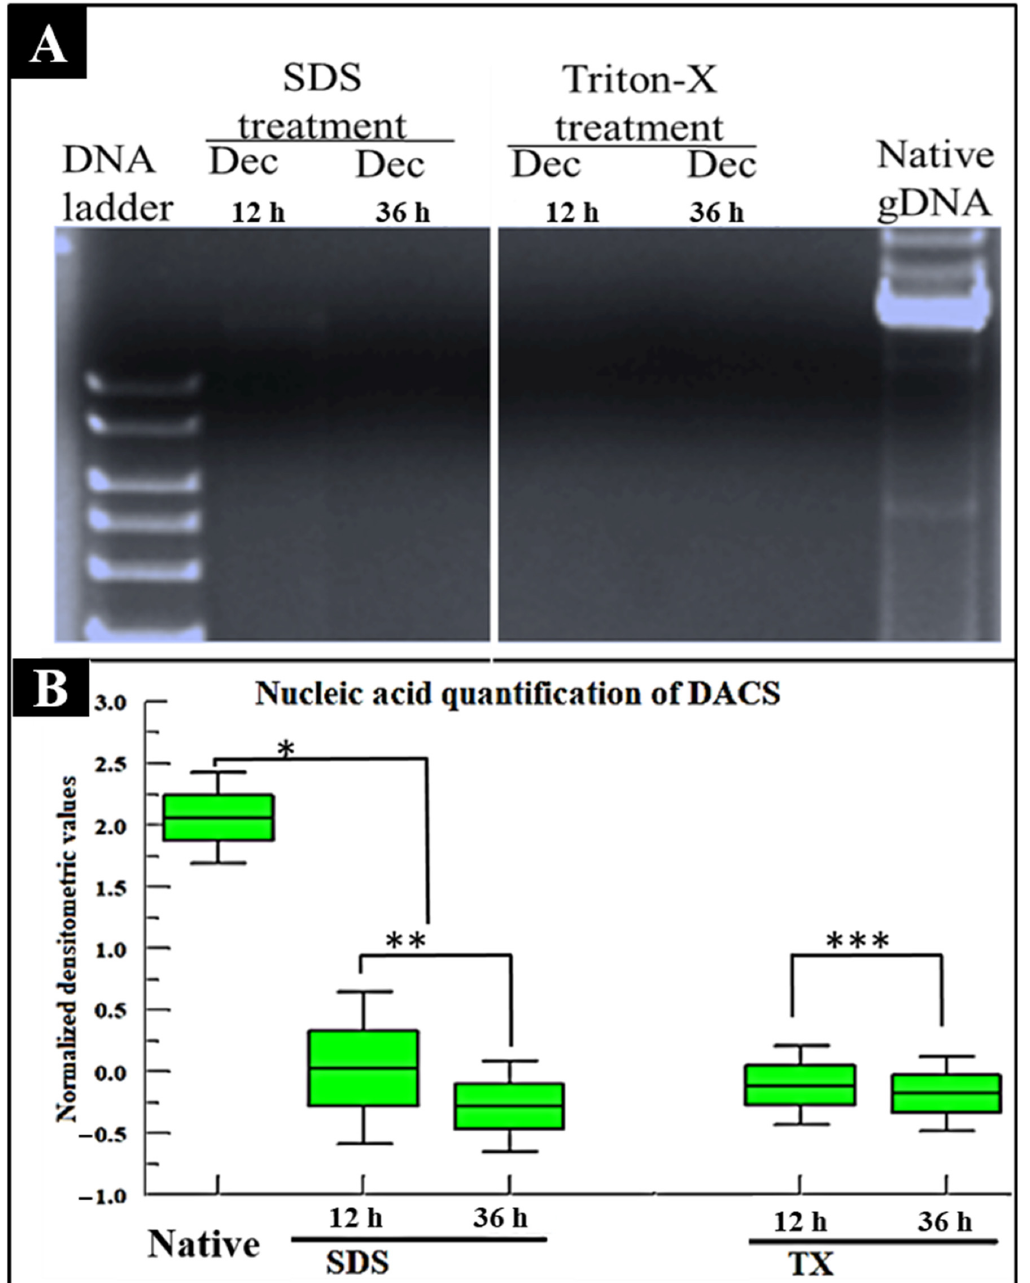
Figure 6. ( A ) Agarose gel analysis of DNA content of decellularized cartilage tissue after 1% SDS or 1% Triton-X treatment. ( B ) Nucleic acid quantitation of decellularized cartilage tissue for set time points after 1% SDS decellularization treatment or 1% Triton-X decellularization treatment. DACS = Decellularized avian articular Cartilage Scaffold. p < 0.05, n = 3. Data reported as mean values ±SEM, Student t -test. ( n = 3, * p- value < 0.001, ** p- value = 0.631, *** p- value = 0.9408).